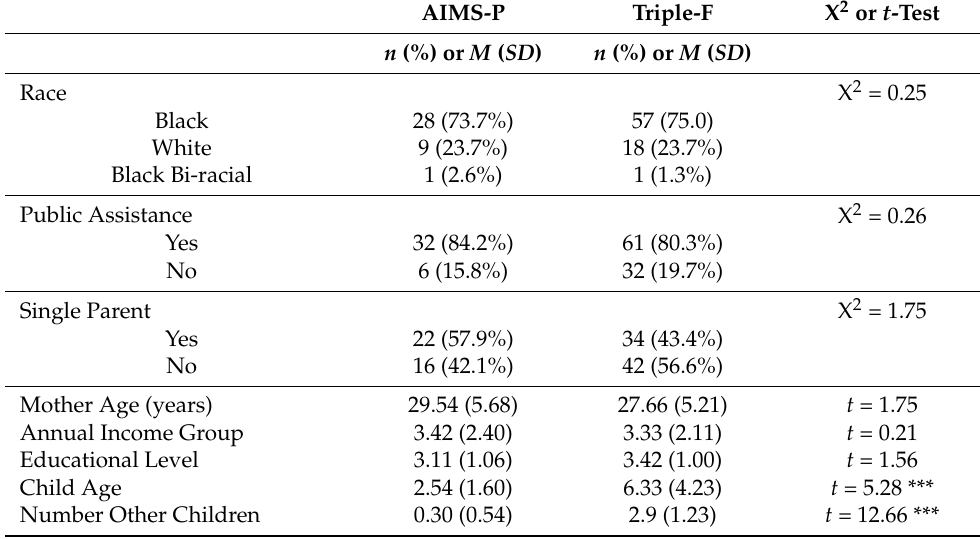
Table 1. Demographics by Study